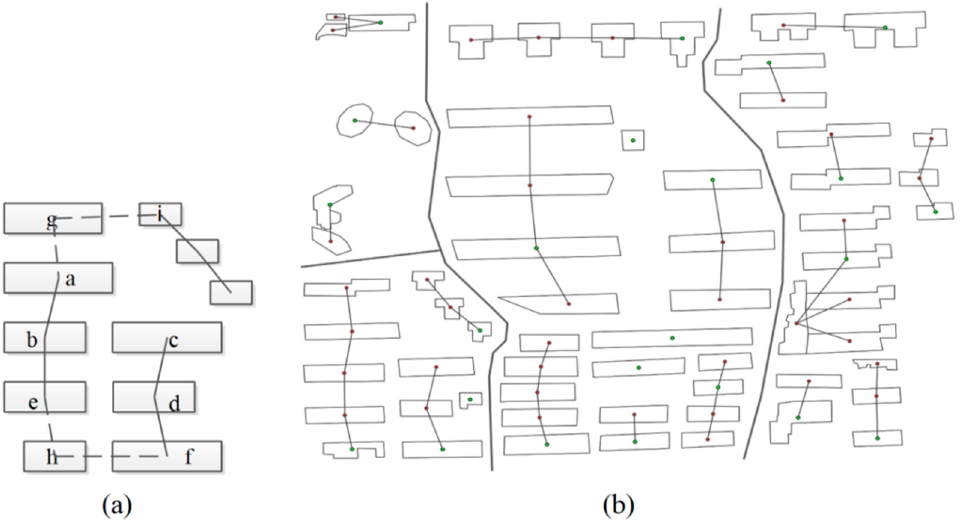
Figure 13. Discrete-model clustering: ( a ) discrete-polygon linking; ( b ) the final proximity